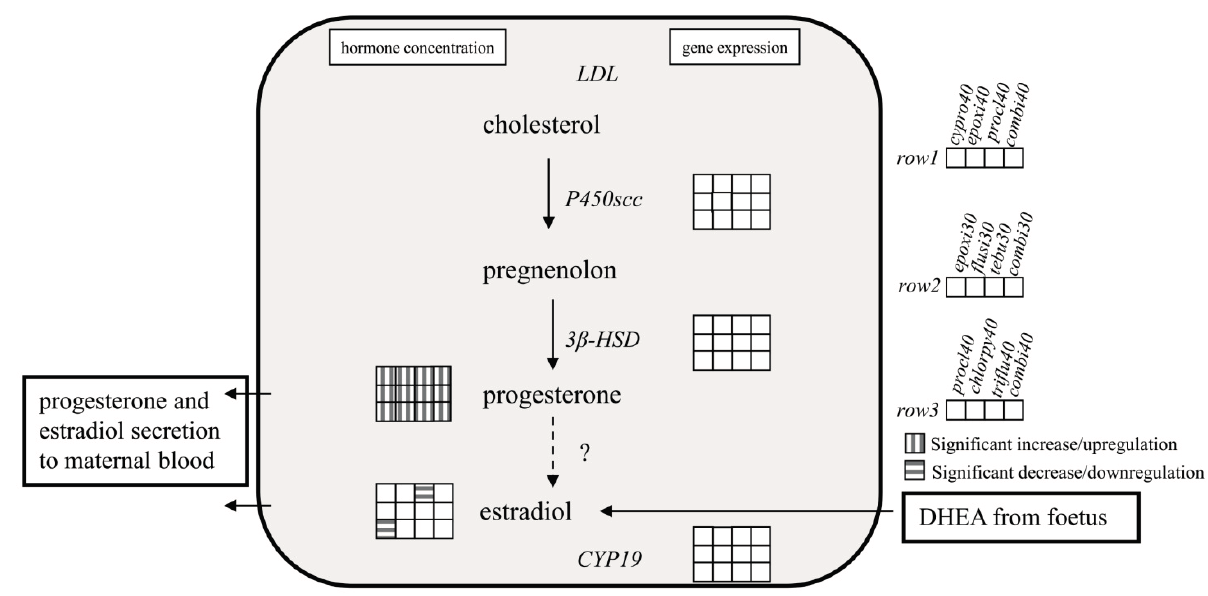
Figure 3. Scheme of expression of steroid biosynthesis relevant genes and supernatant hormone concentration of progesterone and estradiol in trophoblasts based on experiments in Jeg-3 cells. Jeg-3 cells were treated with either 30 µM or 40 µM (as indicated) of cyproconazole, chlorpyrifos, epoxiconazole, flusilazole, prochloraz, tebuconazole and triflusulfuron-methyl individually and in combination for 48 hours. Gene expression was analysed by quantitative real-time PCR. Progesterone and estradiol were measured using commercial ELISA systems. Key on the right side indicates the order of presentation for the concentration groups as well as significant increase/upregulation and decrease/downregulation. The data represent the mean ± SD for three independent experiments. Concentration values given for combination treatments reflect total concentrations of all three